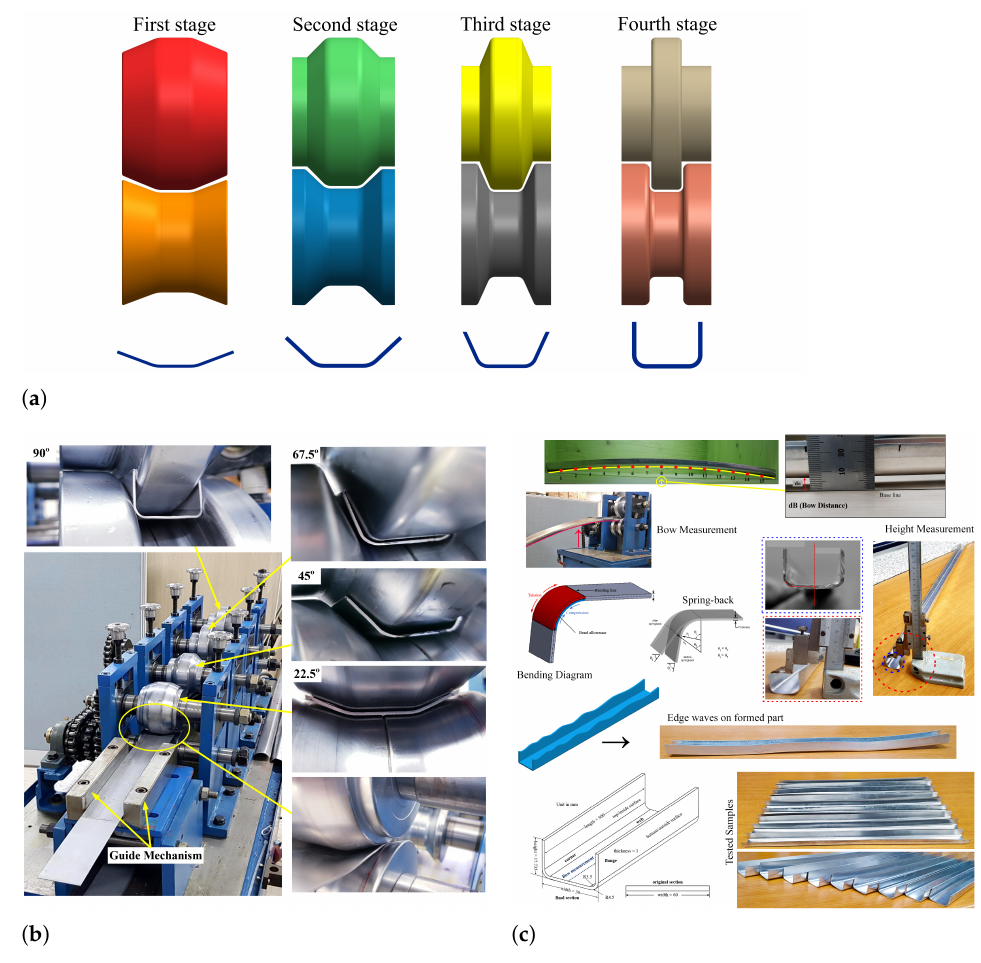
Figure 4. ( a ) Schematic representation of cold roll forming; ( b ) cold roll forming experimental set–up; ( c ) measurement procedures on finished part, such as bow, height, cross-section and spring-back, after forming